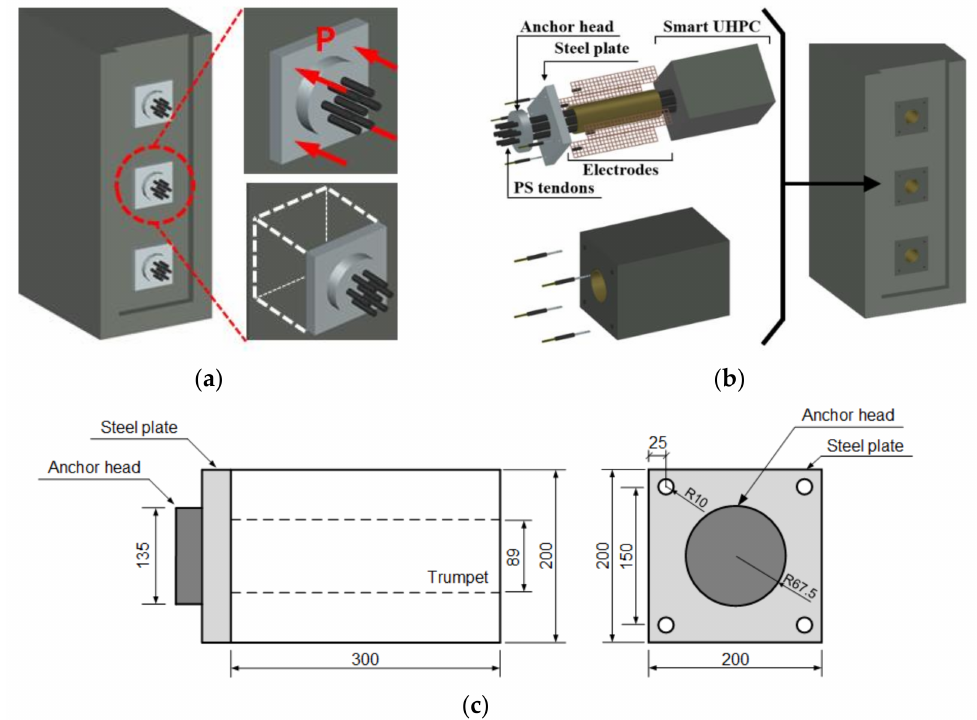
Figure 3. Proposed smart concrete anchorage system: ( a ) anchorage zone in the PSC structure; ( b ) smart concrete anchorage system; ( c ) design of smart concrete anchorage